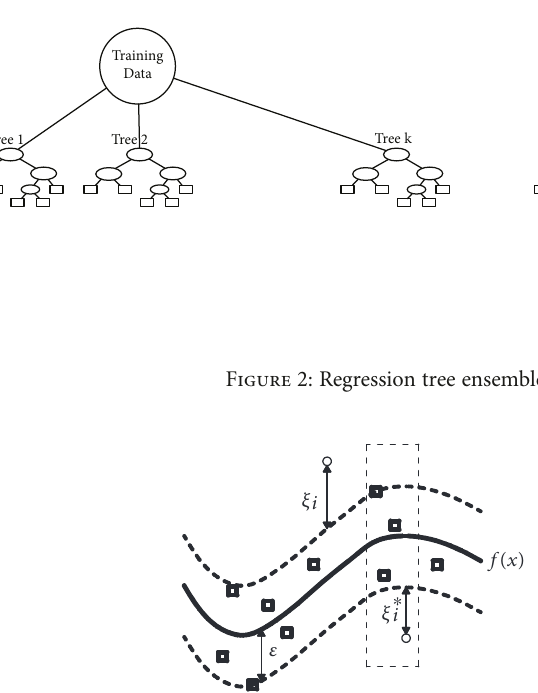
Figure 3: Example of support vector regression: smaller than ε errors are not relevant, while larger deviations are penalized in a linear fashion. “ Loss ” is the penalty for larger than ε